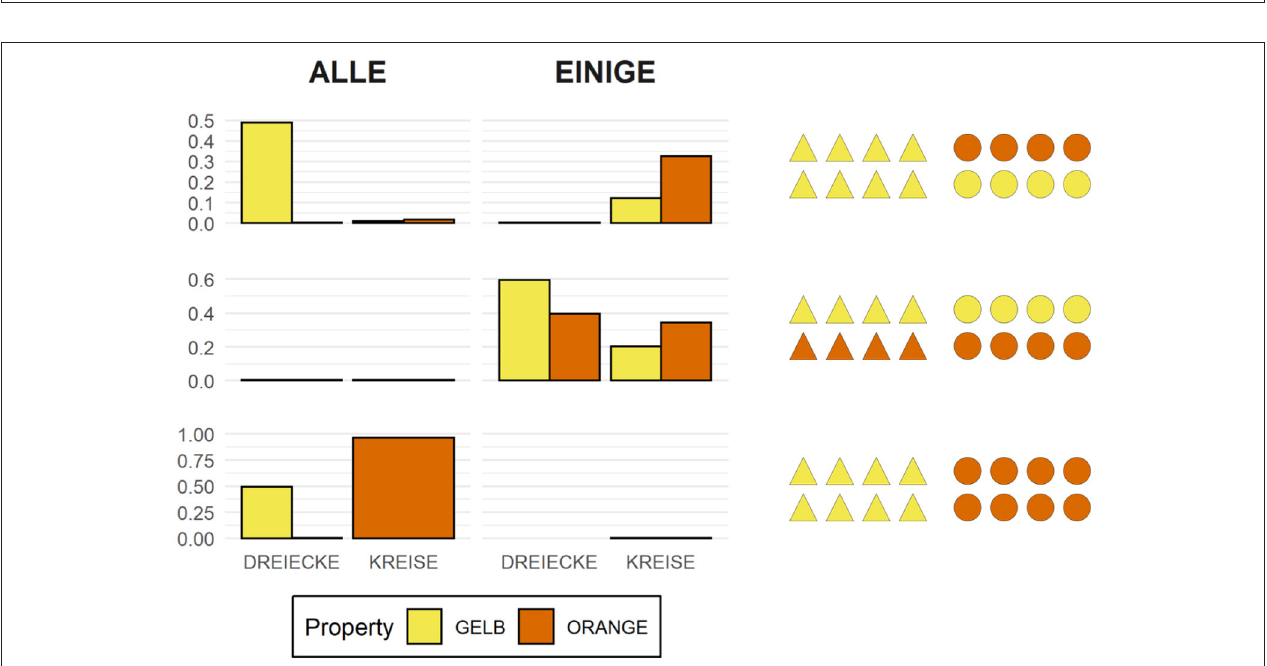
FIGURE 2 | Sample visual scenes. Scenes in the first column contain one homogeneous shape array and one heterogeneous shape array; scenes in the second column contain two heterogeneous shape arrays; scenes in the third column contain two homogeneous shape arrays.